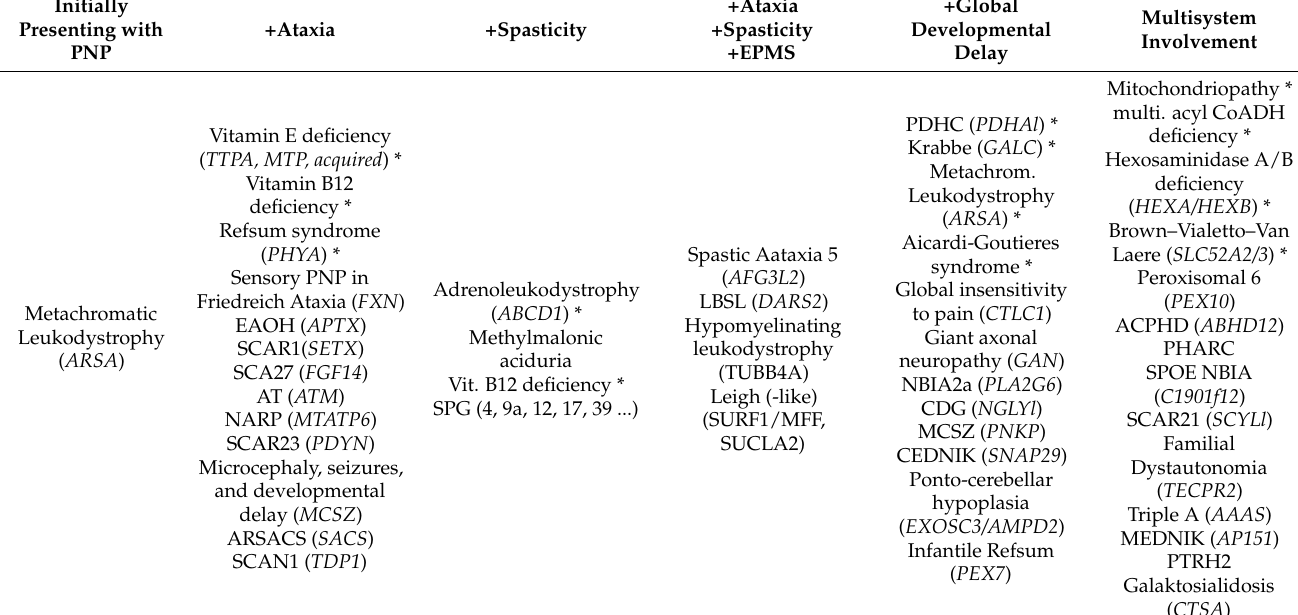
Table 7. Polyneuropathies in systemic neurological diseases with onset in childhood or adolescence. Initially Presenting